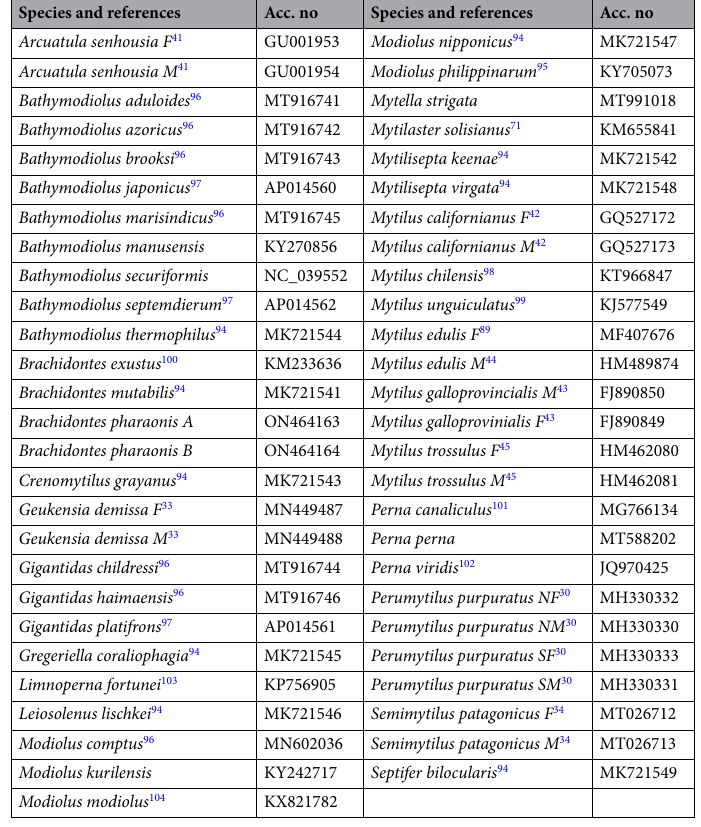
Table 3. List of mitogenomes used in phylogenetic analysis, with species, accession numbers, and references (wherever available). All species names have been updated according to the WoRMS (World Register of Marine Species) database (accession date July